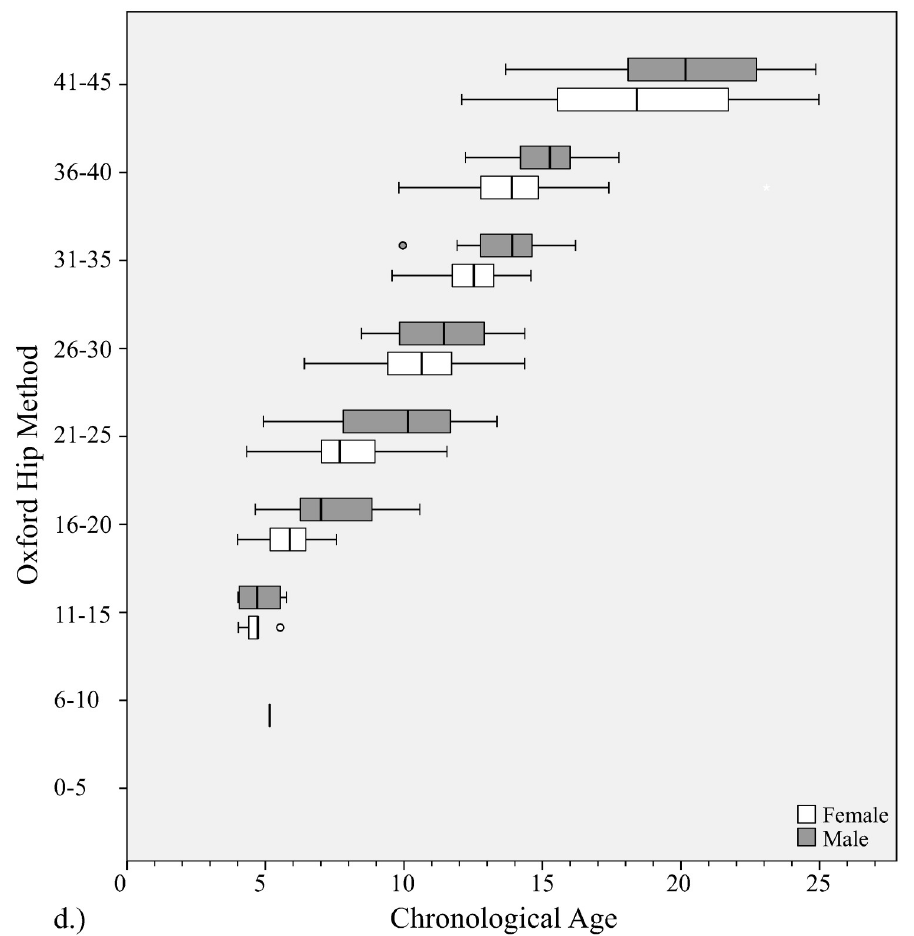
Fig 6. Distribution of chronological ages at each bone age stage with Oxford hip method. Gender is shown at each stage.